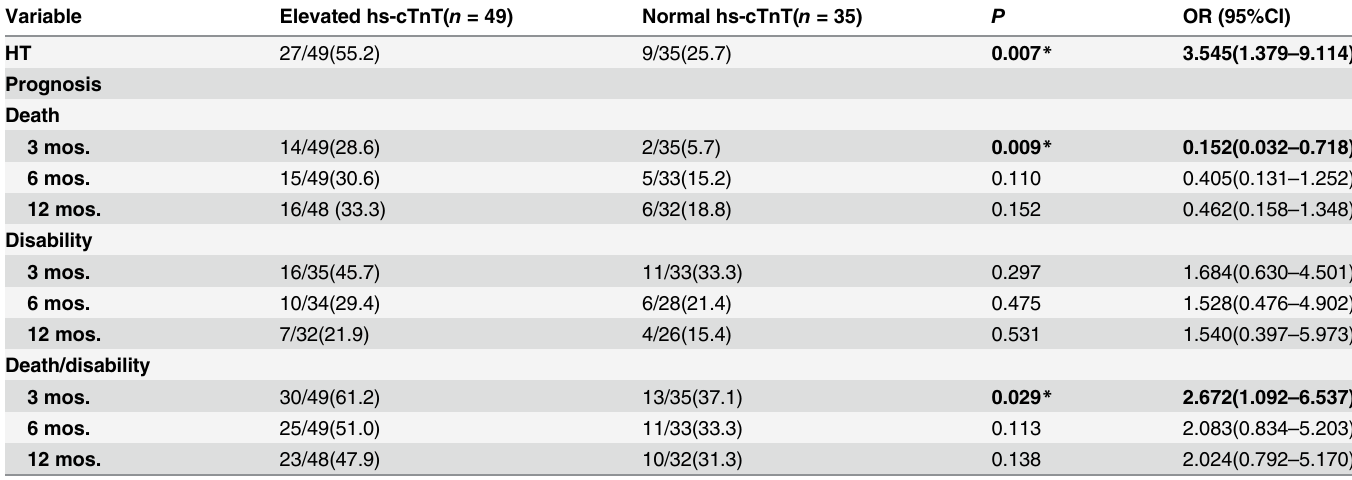
Table 3. Univariate analysis of hemorrhagic transformation(HT) or prognosis in patients with elevated or normal hs-cTnT